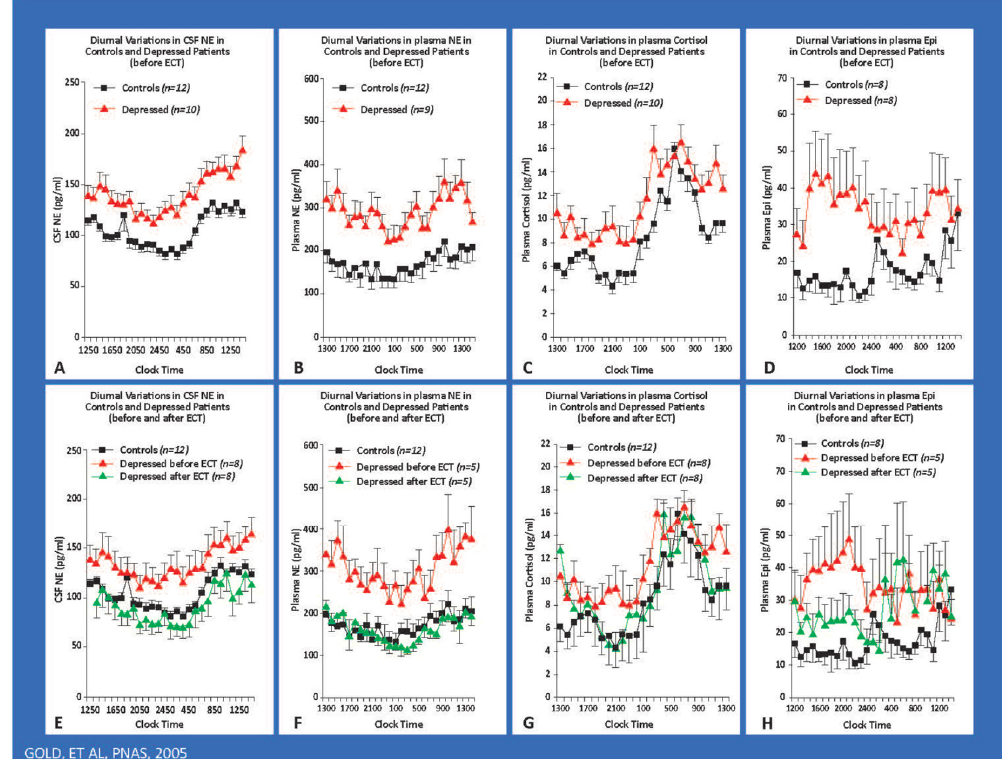
Figure 1. The hypernoradrenergic state of depression as assessed by around-the-clock hourly CSF and plasma sampling. The hypernoradrenergic state of melancholic depression. Hourly around-the-clock sampling of CSF NE, plasma NE, plasma cortisol, and plasma epinephrine in severely depressed, medication-free patients with melancholic depression. We studied patients during depression and after ECT-induced remission. Severely depressed patients had concomitant elevations of the hourly 24 h levels of CSF NE, plasma NE, plasma and CSF epinephrine, and plasma cortisol. These levels all fell to normal levels after ECT. The diurnal variations of CSF NE, plasma NE, and plasma cortisol were virtually superimposable and highly correlated with one another. Their arithmetic means also were highly correlated. These arousal-producing compound levels all peaked at 08:00 to 09:00, a time when melancholic symptoms are at their worst. Their peaks also coincide with the time for maximal susceptibility to myocardial infarction and sudden death. CSF NE and plasma norepinephrine correlate with one another, yet they derive from different sets of neurons. Patients with the Shy Drager syndrome have very low plasma norepinephrine levels in association with robust CSF norepinephrine concentrations. Excessive central norepinephrine secretion in melancholia exerts several adverse effects. Norepinephrine inhibits critical structures in the prefrontal cortex such as the subgenual and dorsolateral prefrontal cortices. NE stimulates the amygdala and the CRH/HPA axis. Central noradrenergic excess also contributes to hypertension, activation of the HPA axis, and the sympathetic nervous system. Plasma and CSF epinephrine were also elevated around the